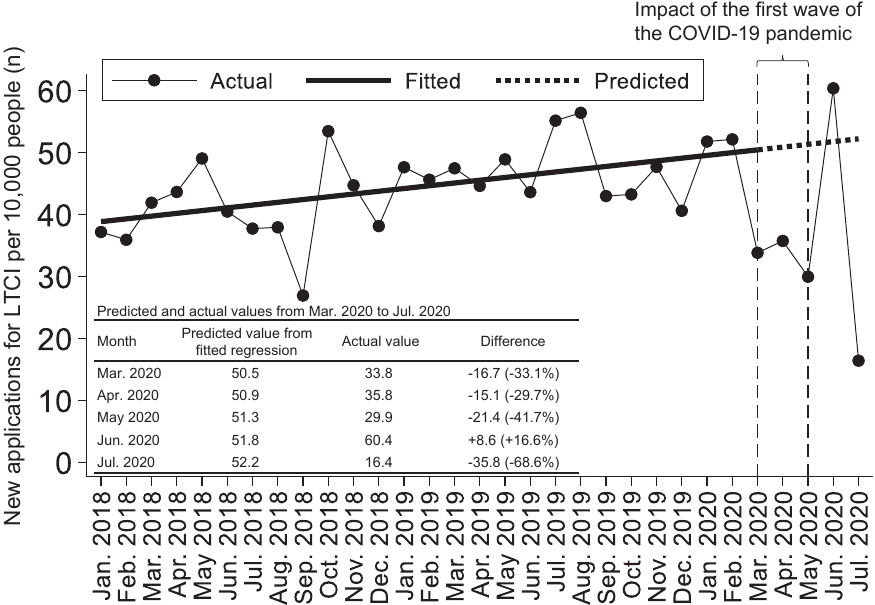
Figure 1. Number of new applications for LTCI per 10,000 people from January 2018 to July 2020 in Ota City cohort. The solid line shows the regression line applied to the number of new LTCI applications from January 2018 to February 2020. The dotted line shows the predicted values based on the regression. The movements of the WHO and the